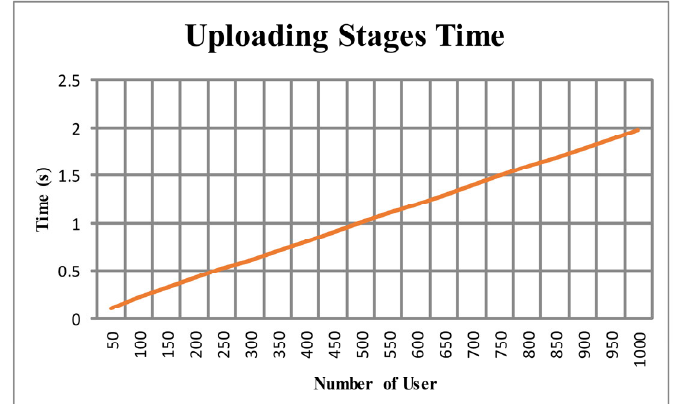
Figure 3. Computation cost of the uploading stages in the semi ‐ trust server.